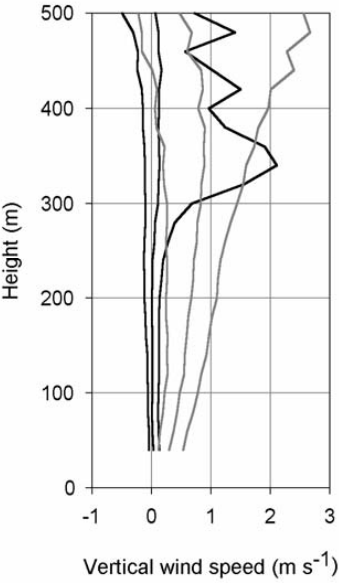
Fig. 3. First, second and third quartiles of potential temperature gradient during the day (in grey) and night (in